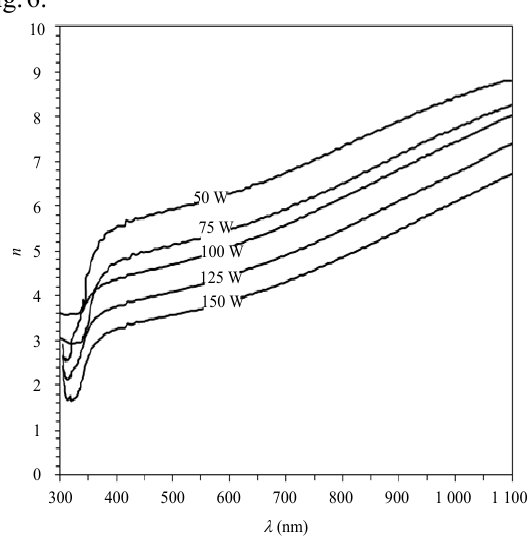
Fig. 9 Refractive index as a function of wavelength for (Ti6Al4V) thin film at different working RF